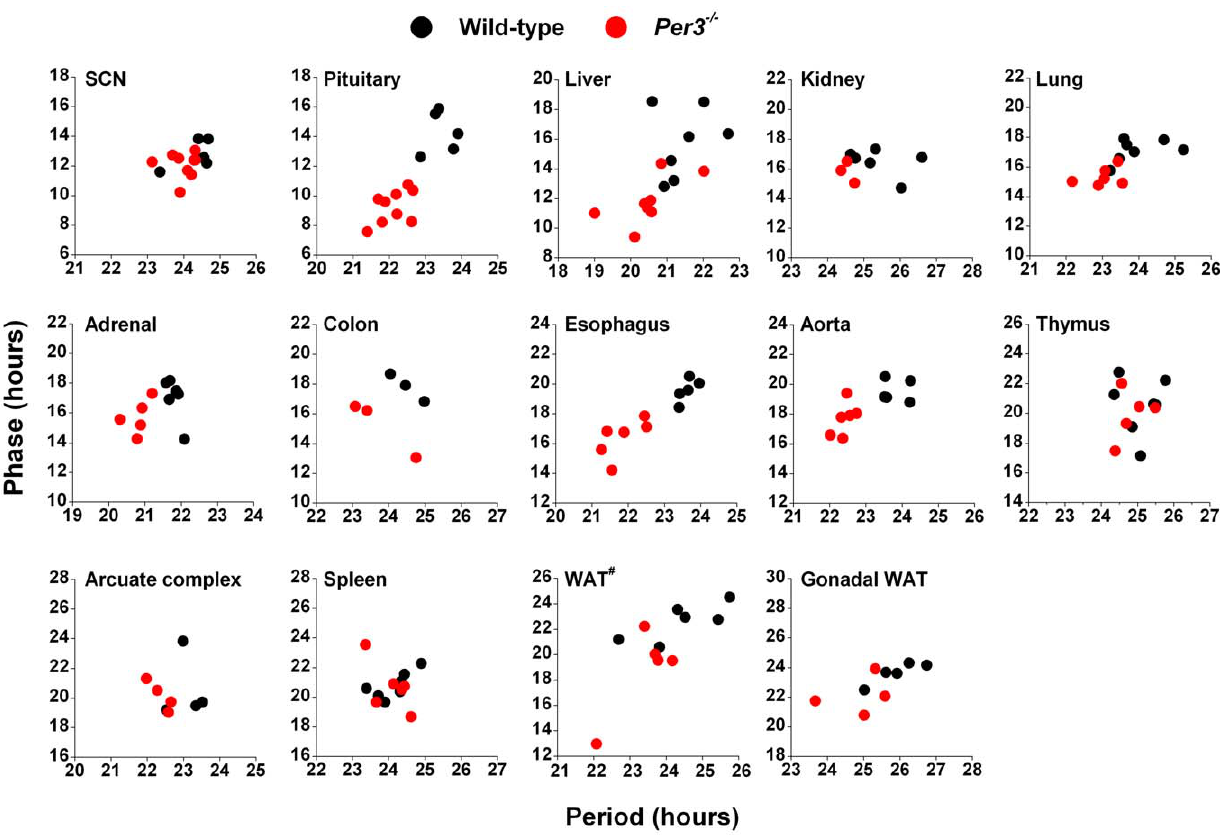
Figure 3. Tissue-specific relationships between phase and period in wild-type and Per3 2 / 2 mice. The phase of each sample was plotted relative to its endogenous period of PER2::LUC expression. All samples for which both phase and period could be analyzed are shown. Wild-type (black circles) and Per3 2 / 2 (red circles) samples are plotted on the same graph for each tissue. WAT # : white adipose tissue surrounding the adrenal gland.